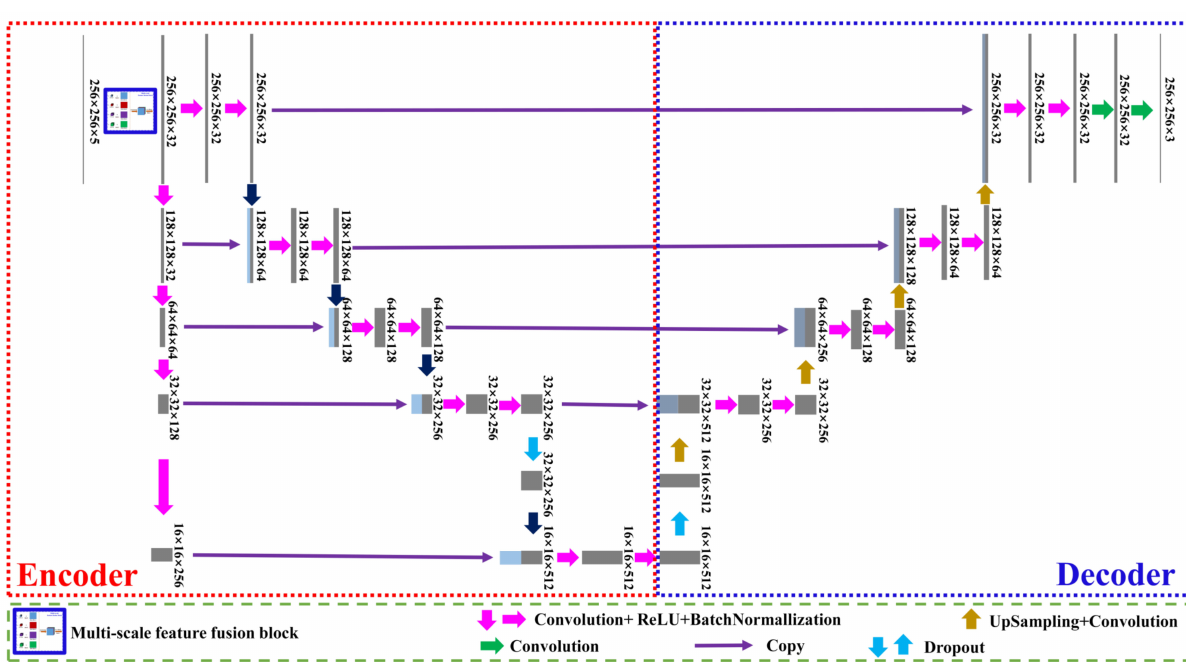
Figure 14. Multi-Scale